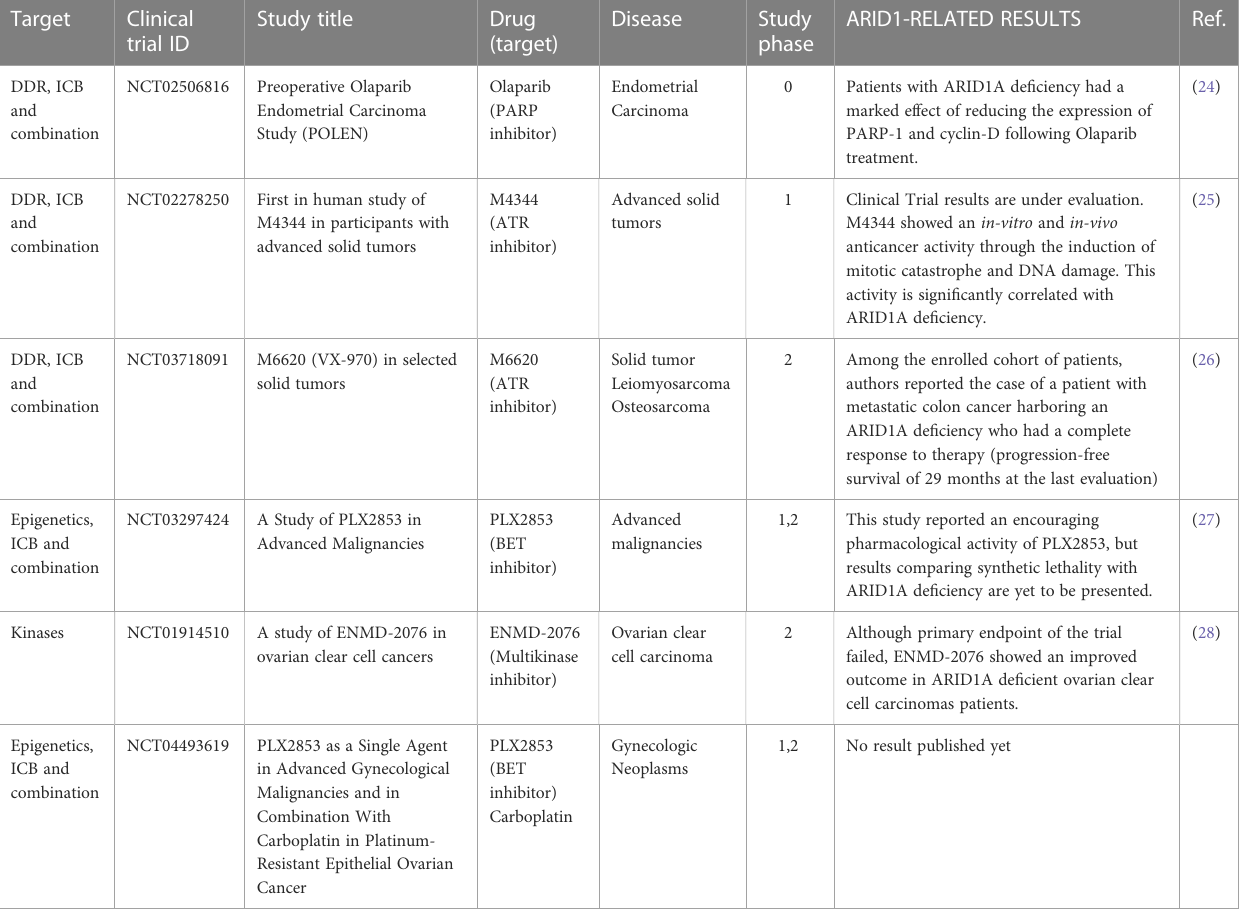
TABLE 1 Completed clinical trials involving cancers with ARID1A de fi